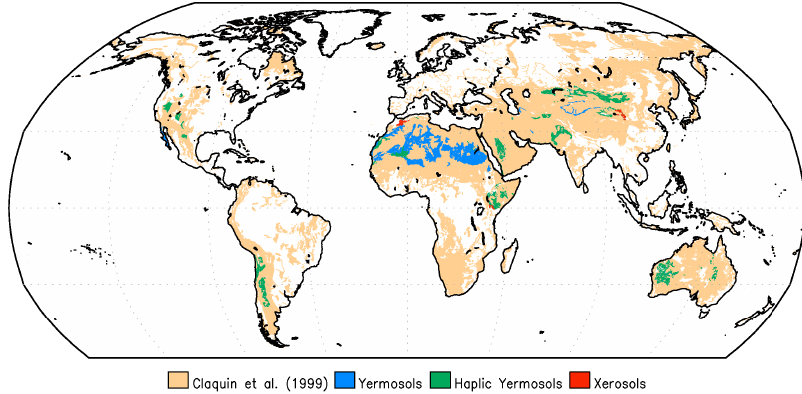
Fig. 3. Global distribution of the soil types selected by Claquin et al. (1999) with three new selected soil types: Yermosols, Haplic Yermosols and Xerosols.